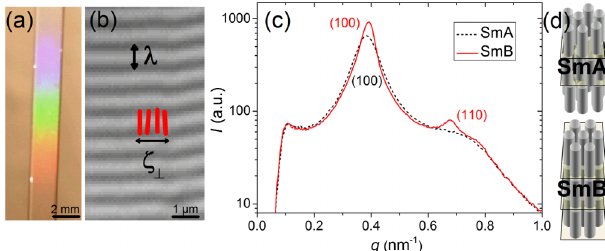
FIG. 5. (a) Iridescence of macroscopic smectic sample illumi- nated by a white light source. (b) Optical texture of the smectic phase observed by differential interference contrast microscopy evidencing the layer spacing λ . The red rods schematically represent the fd viruses within the layers, and the associated positional correlation length ζ ⊥ normal to their long axis. (c) Scattered intensity obtained by SAXS probing the transla- tional order within the smectic layers showing the evolution from liquidlike (dotted black line) to hexagonal positional (solid red line) order by slightly increasing the rod concentration. This corresponds to the SmA and SmB phases, respectively, as schematically represented in